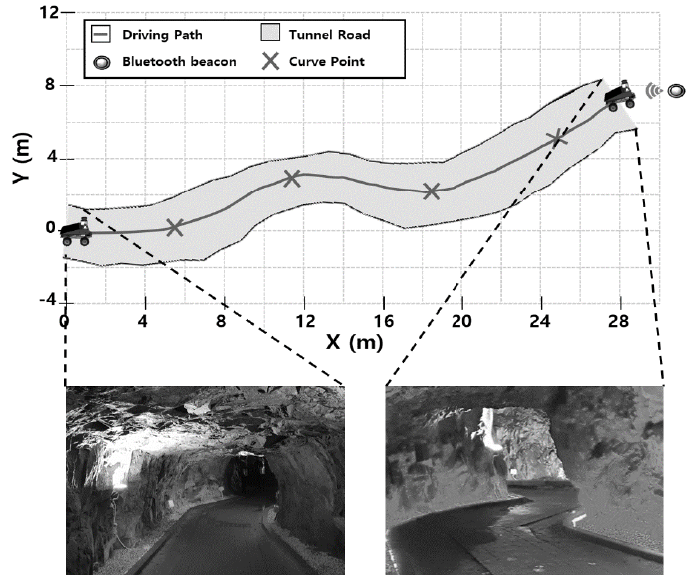
Figure 10. Conceptual diagram of the field experiment in the underground mine environment.